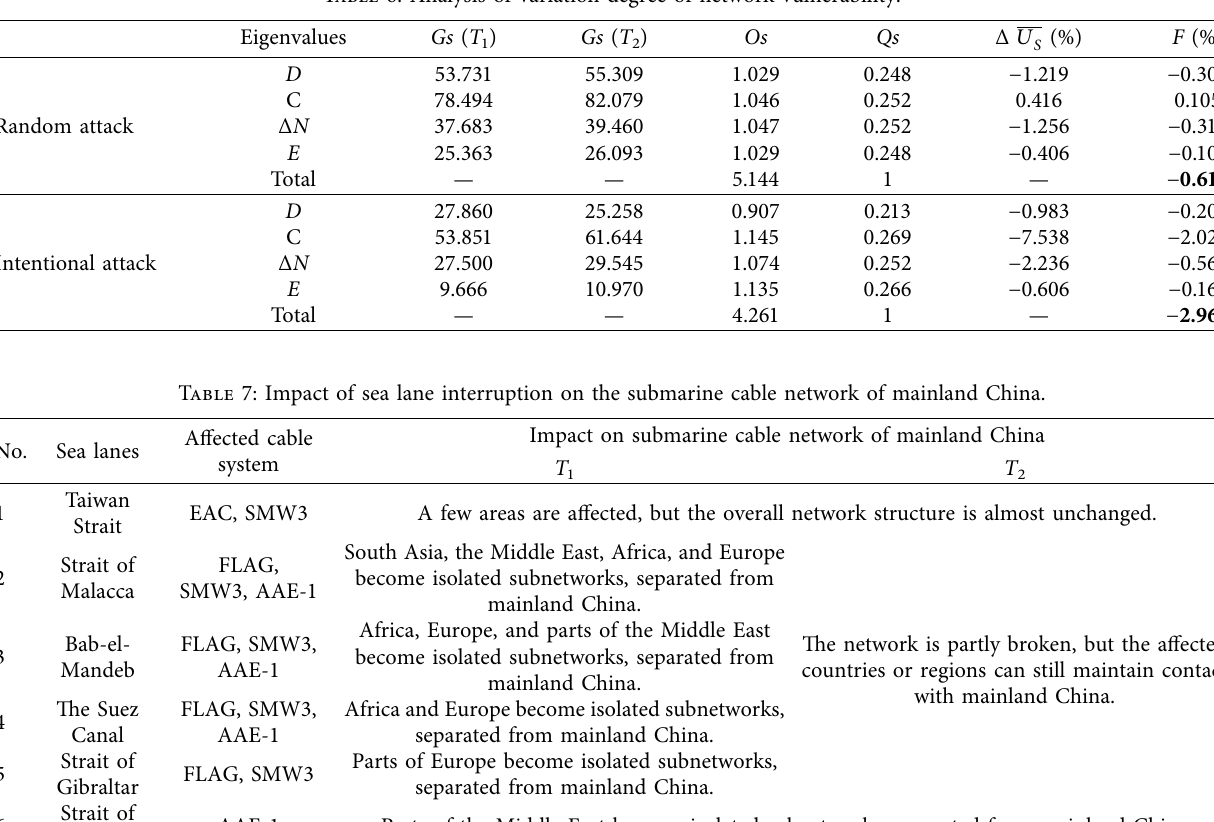
Table 6: Analysis of variation degree of network vulnerability.